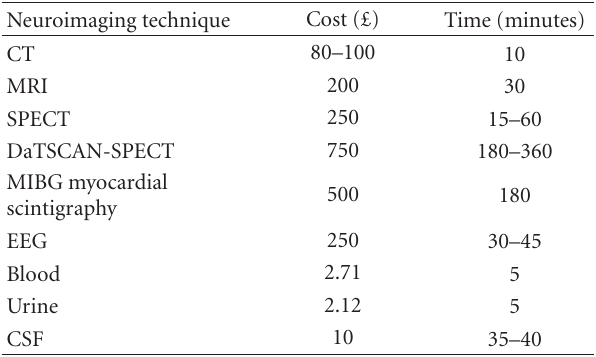
Table 2: Cost and time implications of neuroimaging and neuro- physiological techniques and laboratory